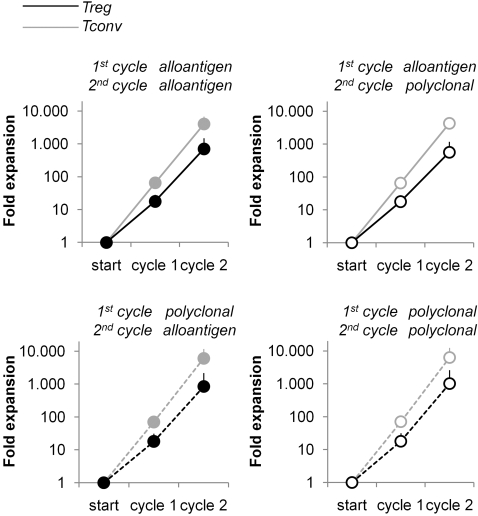
Treg expansion after primary and secondary cycles with alternated alloantigen or polyclonal stimulation.Treg and Tconv were expanded according the schedule in Figure 1 and rested for two days. Treg numbers were determined and related to Treg numbers at initial set up. Data represent average expansion +SD of seven independent experiments.